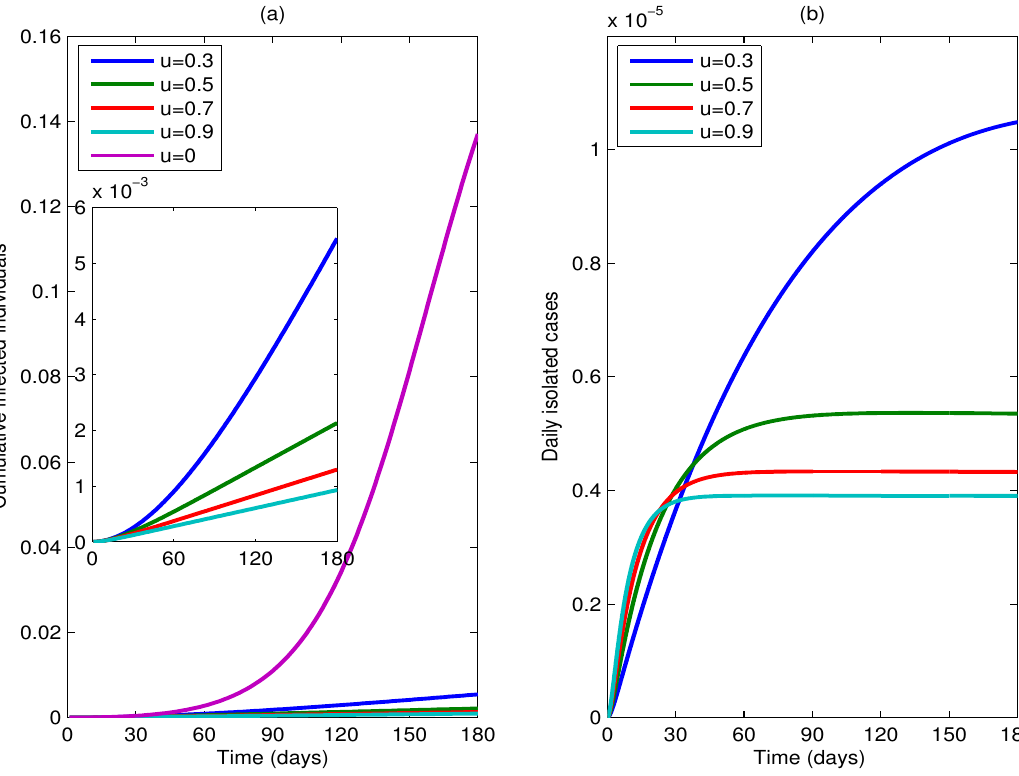
Figure 3. ( a ) Plots of the cumulative percentage of infected individuals up to time t ; and ( b ) plots of the percentage of isolated cases versus time t , as predicted by the model (1) with parameters: R = 1 . 5 , a = 0 . 6 , b = 0 . 2 , m = 15 and other parameters supposing the 0